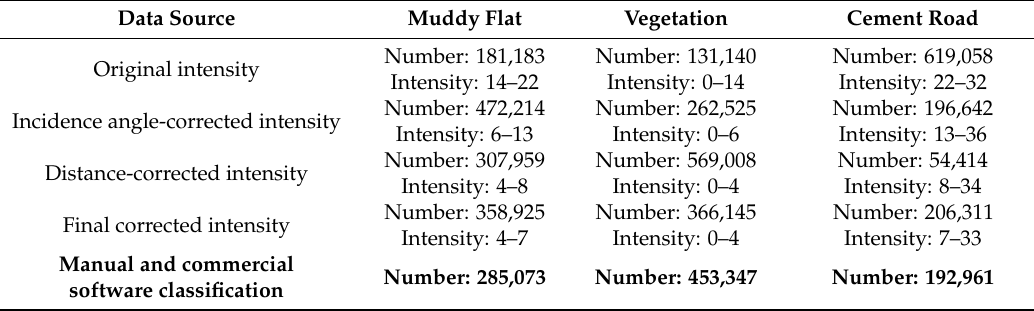
Table 4. Point cloud classification results by different data sources.